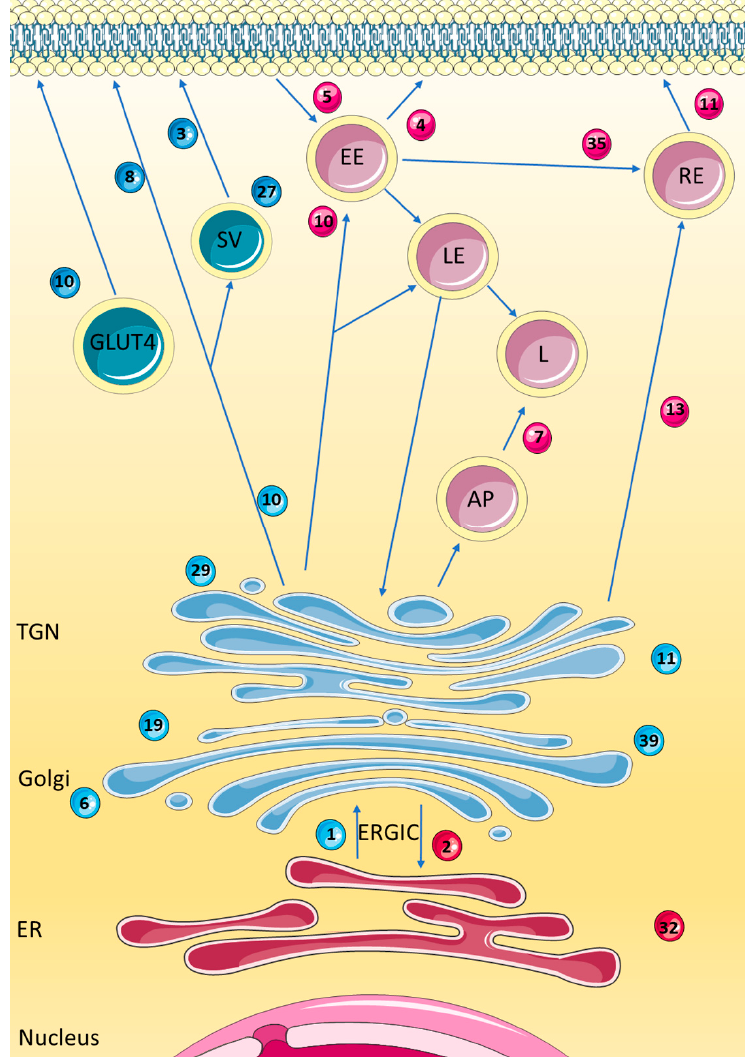
Figure 1. The Intracellular pathways and a selected number of Rab GTPases associated with the endoplasmic reticulum (ER), Golgi, trans ‐ Golgi network (TGN), and endosomal pathways. Rab1 and Rab2 are localised to the ER and Golgi, and play a role in the ER to Golgi apparatus trafficking pathway, via the endoplasmic reticulum to Golgi intermediate compartment (ERGIC). Rab3 is localised to synaptic secretory vesicles (SV) and the plasma membrane and is involved in exocytosis and neurotransmitter release. Rab4 has a role in protein recycling and transport to the plasma membrane and is localised to early endosomes (EE). Rab5 is localised to the EE and aids its fusion and formation. Rab6 is involved with regulating intra-Golgi trafficking. Rab7 is localised to the late endosome (LE), lysosome (L), and autophagosomes (AP) and is involved in the maturation and transport between these vesicles. Rab8 is associated with exocytosis from the TGN to the plasma membrane, with localisation to the plasma membrane and SV. Rab10 is localised to the ER, Golgi, endosomes, and GLUT4 vesicles and is involved in ER dynamics, endocytosis, and trafficking to the plasma membrane. Rab11 is also localised to the Golgi, as well as the recycling endosome (RE) and EE. Rab13 is involved in the TGN and RE to plasma membrane transport pathway. Rab19 has been shown to localise to the Golgi, however there is little known about its role. Rab27 is involved in exocytosis, localising to SV. Rab29 and Rab39 are both localised to the Golgi. Rab32 localises to the ER and mitochondria, with a role in mitochondrial dynamics and autophagy. Rab35 localises to the plasma membrane, and is involved in endocytic recycling. Rabs more strongly associated with secretory pathways are shaded in blue while those more strongly associated with endosomal pathways are shown in red. Adapted with permission from Hutagalung et al. 2022, American Physiological Society